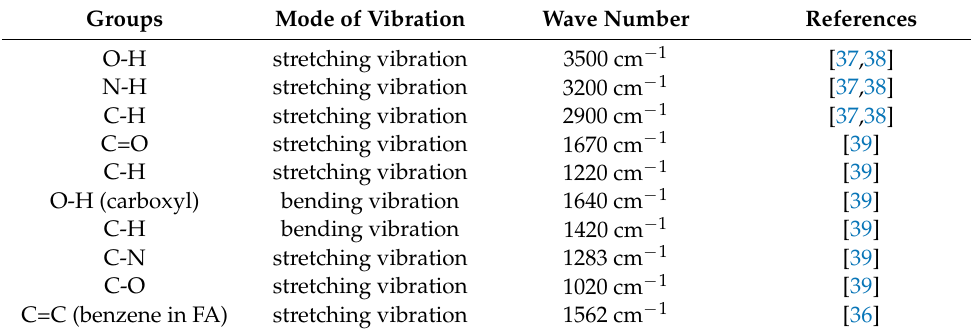
Table 1. FT-IR data of the Ce-CDs-FA.